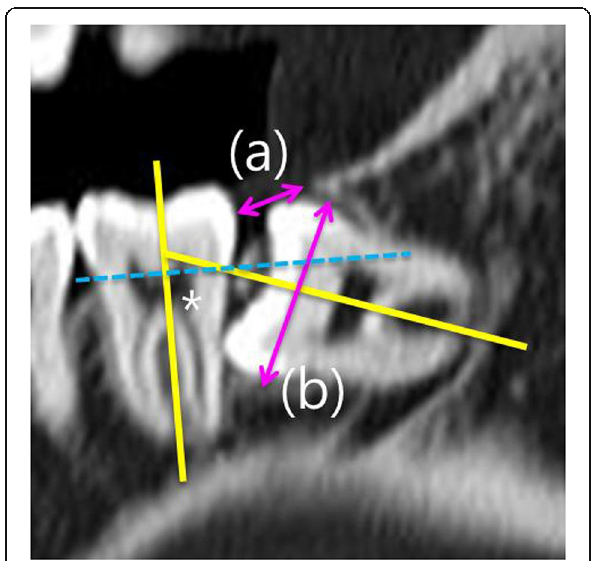
Fig. 1 Assessment of the impacted third molar position in computed tomography according to a previous study [8]. The spatial relationship was classified based on the angle measured between the long axis of the impacted third molar and the adjacent second molar (yellow lines and an asterisk mark). Depth was classified based on the line connecting the cementoenamel junction of the adjacent second molar (dotted blue